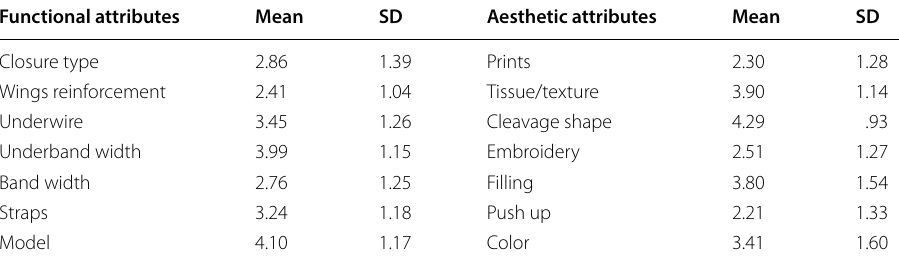
SD standard deviation